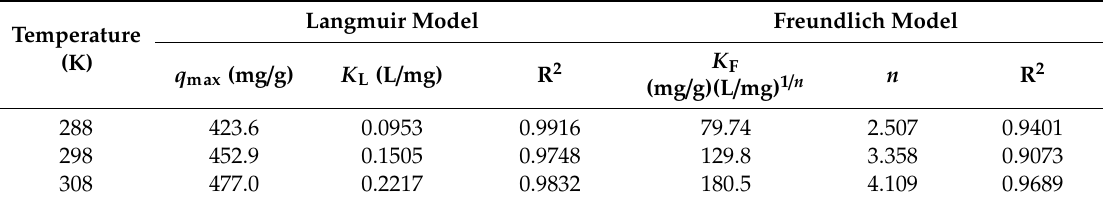
Table 2. Isotherm parameters obtained from the Langmuir and Freundlich models for the adsorption of Hg(II) by the biopolymer at di ff erent temperatures.